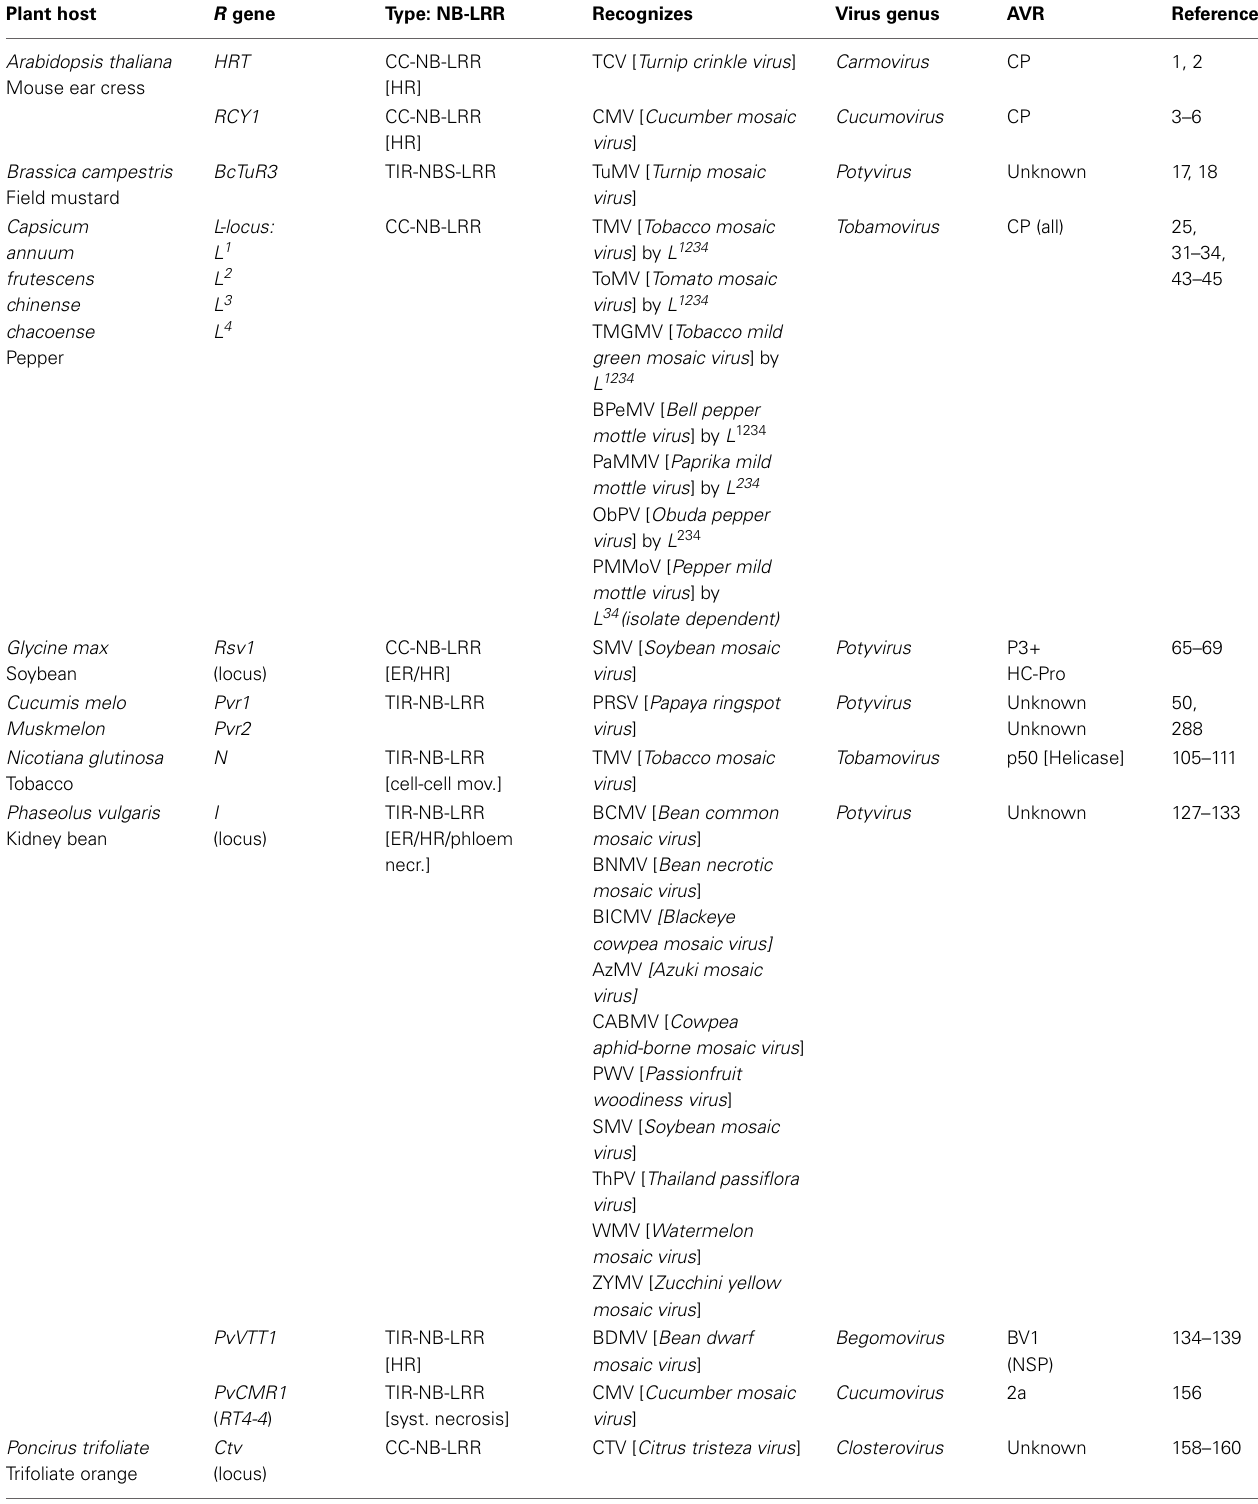
Table 1 | Cloned dominant resistance genes against plant viruses, organized into the NB-LRRs and the non-NB-LRRs, and their Avr determinants (when